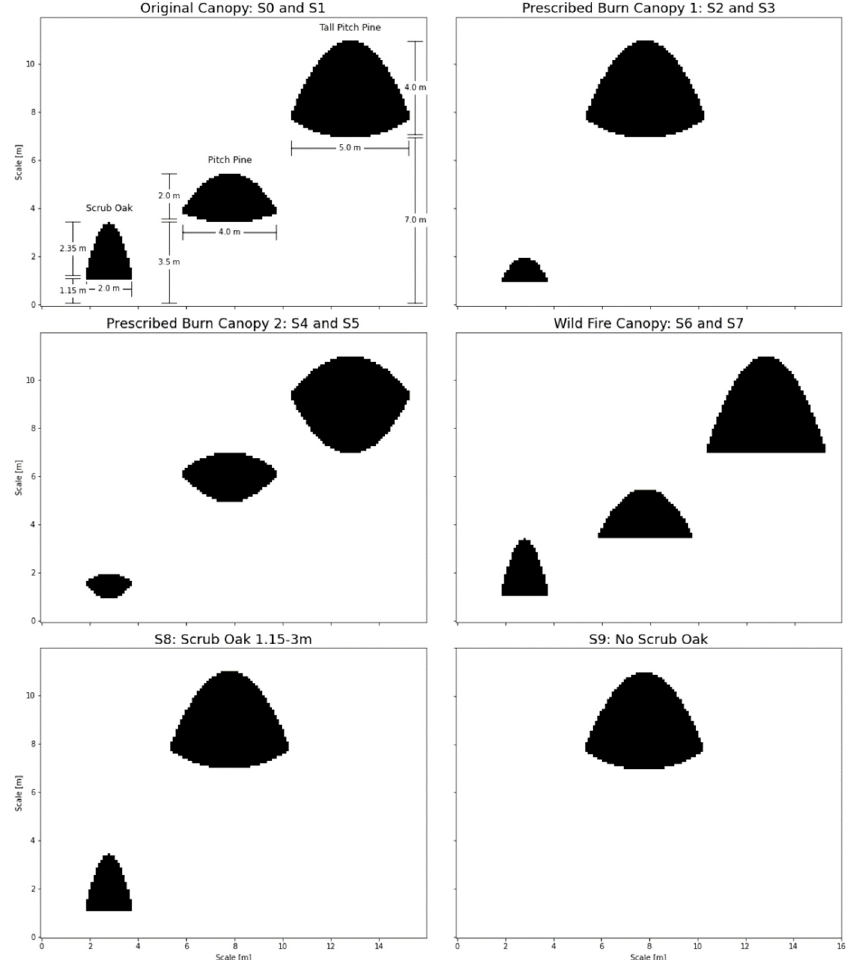
Figure 6. Visualization of woody vegetation parameterization for scenarios S0–S9.